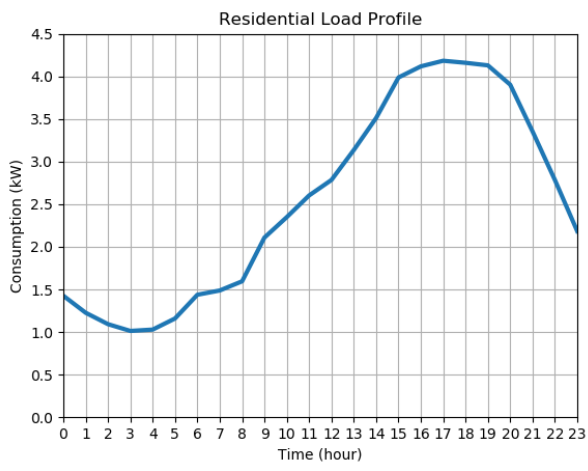
Figure 3. The daily load profile used as the input for all smart meters.